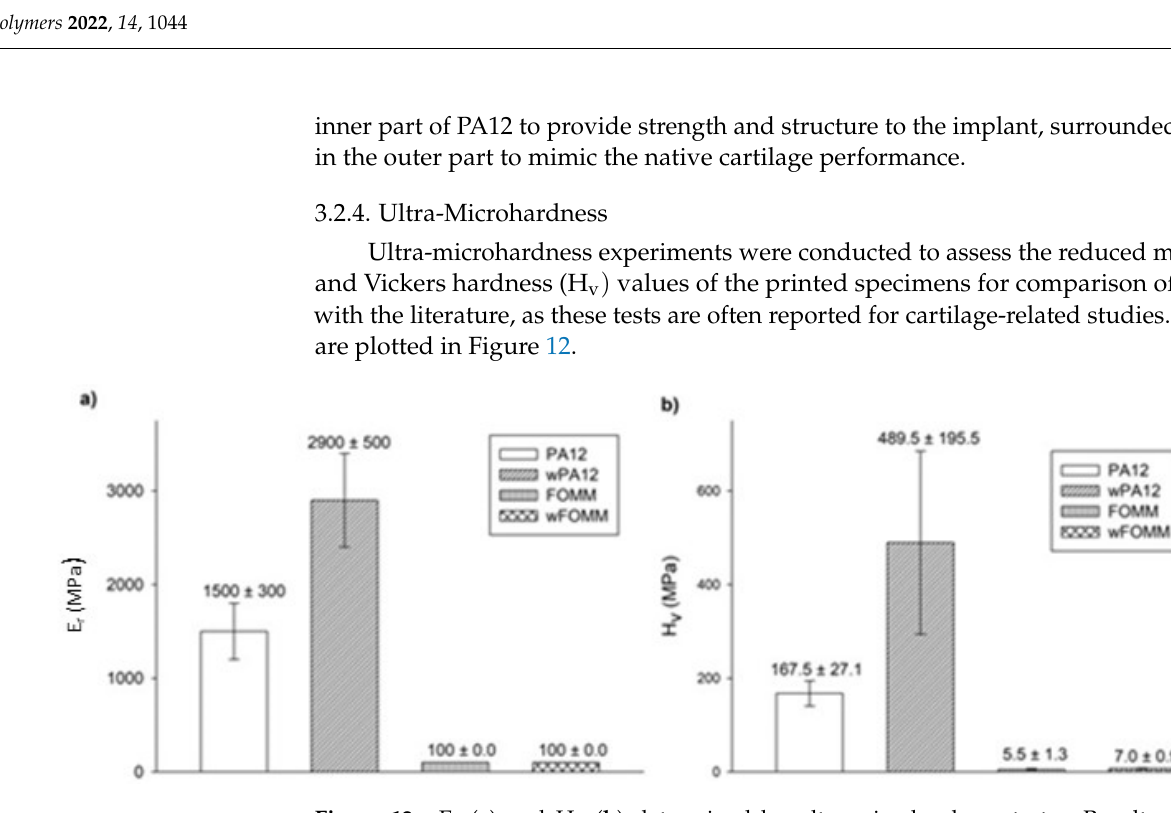
Figure 12. E (cid:2928) ( a ) and H (cid:2932) ( b ) determined by ultra-microhardness tests. Results presented as mean ± Figure 12. E r ( a ) and H v ( b ) determined by ultra-microhardness tests. Results presented as SD. mean ± SD.